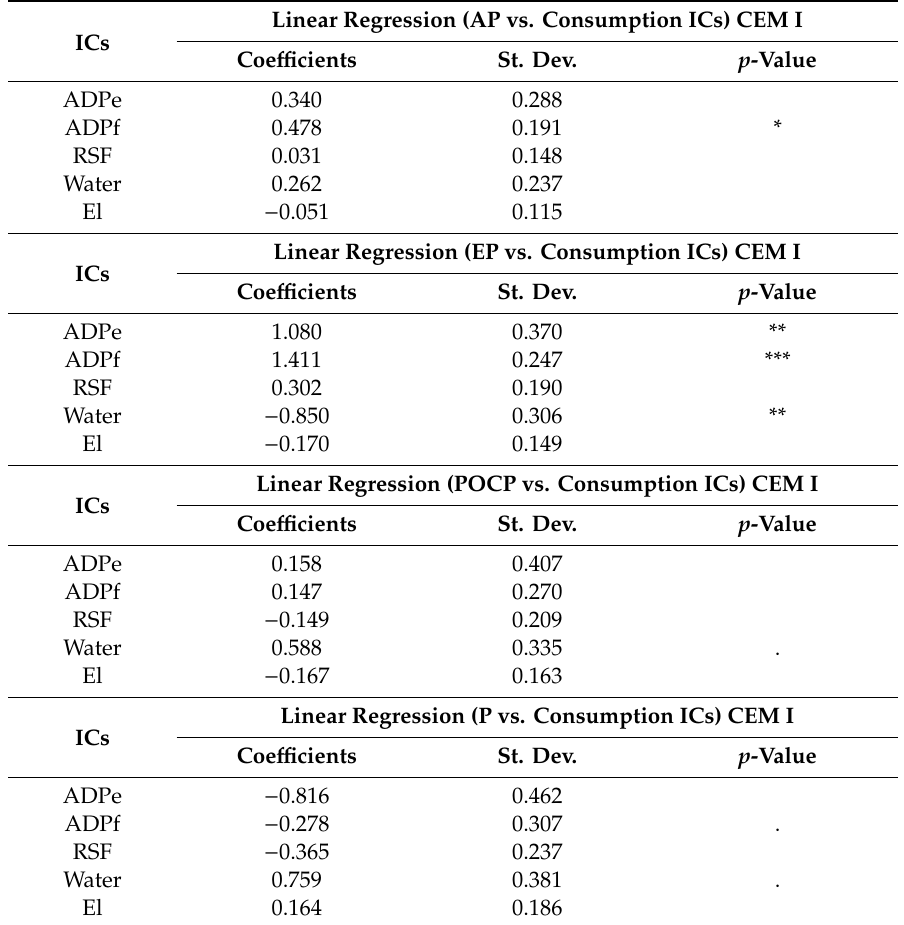
Table 19. AIC selection for GWP regression summary—CEM I.